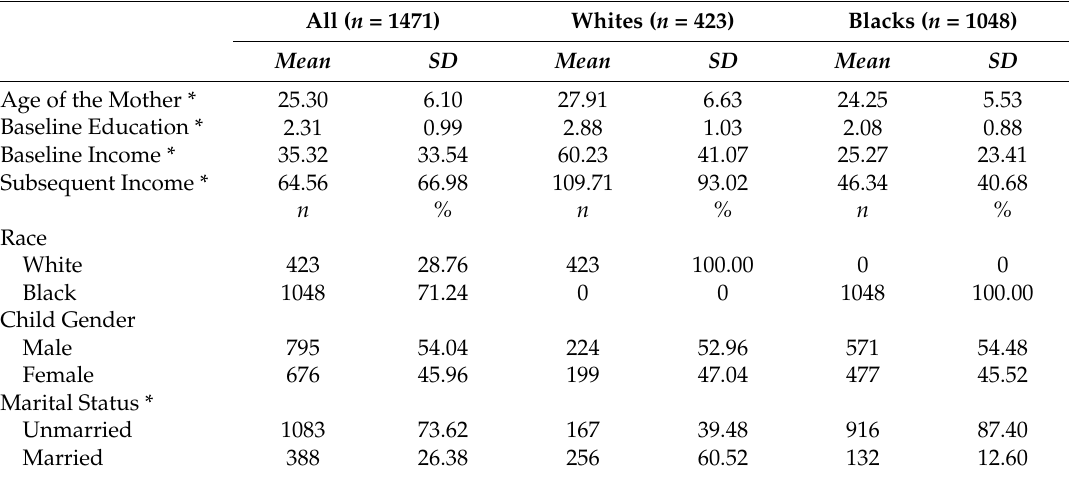
Table 1. Descriptive statistics in the pooled sample and by